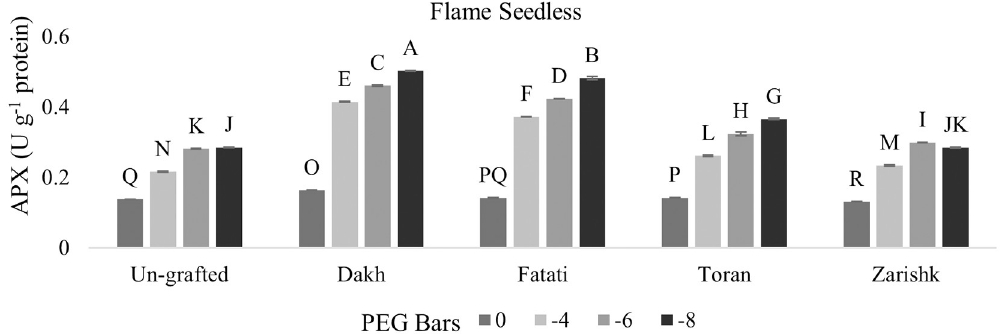
Fig 14. Ascorbate peroxidase (APX) enzymatic activity of un-grafted and grafted Flame Seedless scion variety grafted on different wild grapevines under drought stress condition. Data is represented as mean SD and letters showed significant difference at p < 0.05.